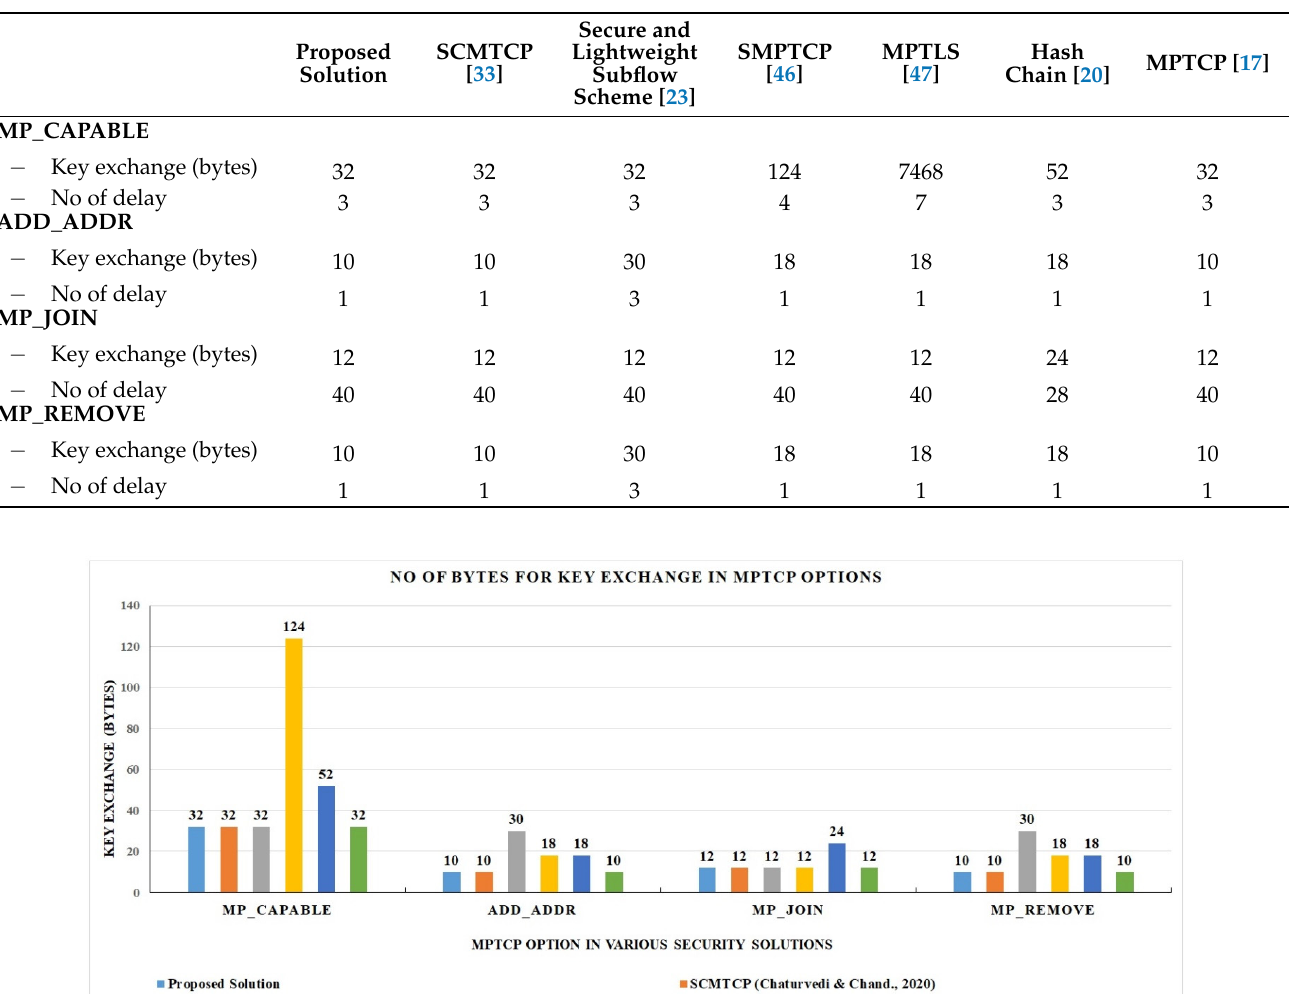
Table 6. Comparative evaluation of existing security solutions.